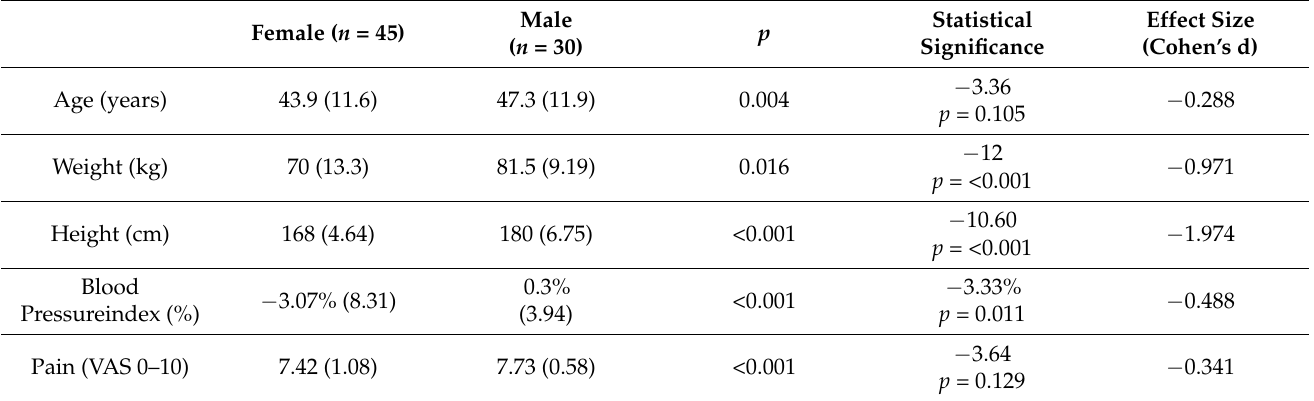
Table 1. Baseline characteristics of the study group (Standard Error) and mean differences between groups.